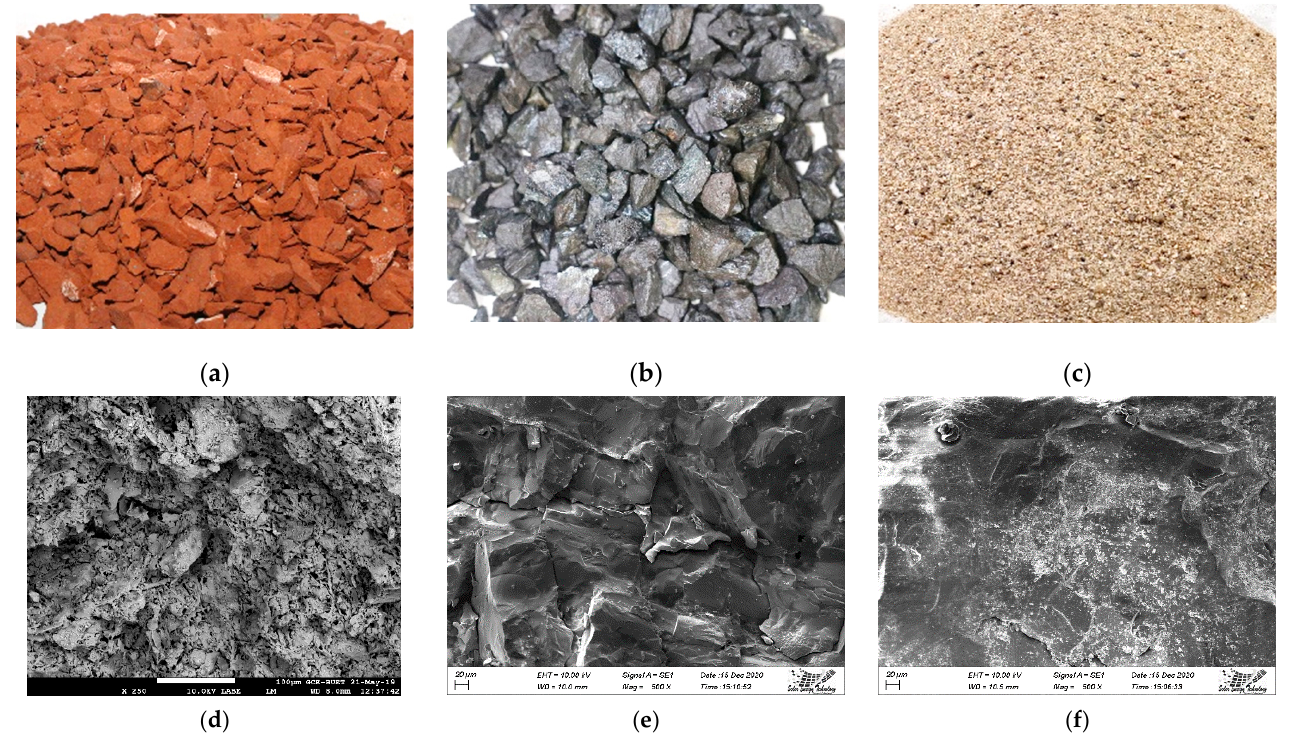
Figure 1. Original image of fired clay brick aggregate-FCBA ( a ), induction furnace steel slag aggregate-IFSSA ( b ), natural sand-NS ( c ), and SEM images of FCBA ( d ), IFSSA ( e ), and NS ( f ), respectively.